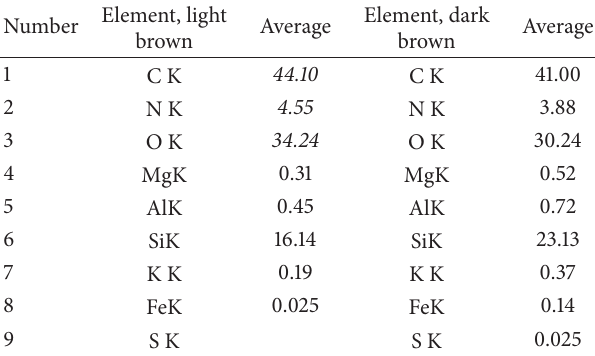
Table 3: Elemental composition of dry GAKVB in the light-brown (yellow) and dark-brown (green) zones, as evaluated by EDX. Element, light Element, dark Number Average Average brown brown 1 C K